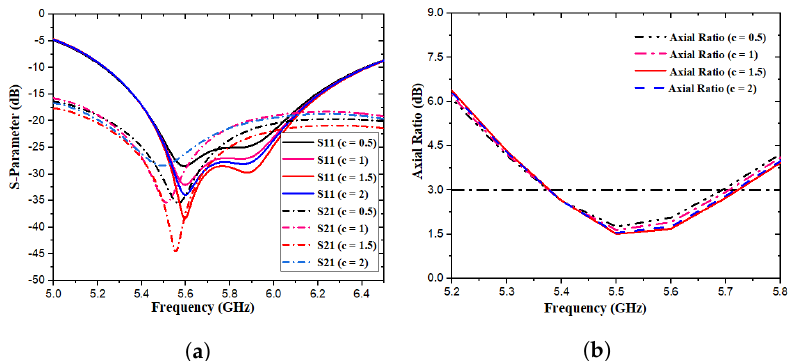
Figure 9. ( a ) Simulated S-parameter for the antennas with different widths of ground slot, c . ( b ) Sim- ulated axial ratio of different widths of ground slot, c